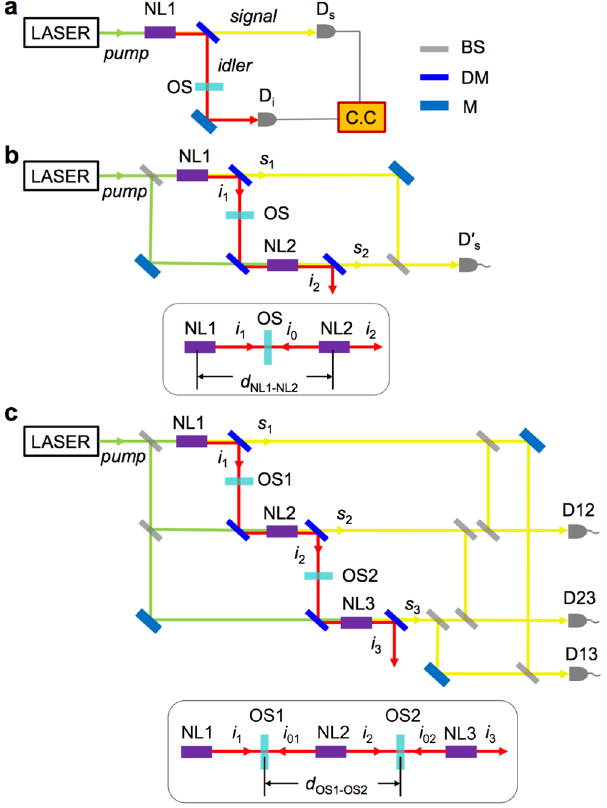
Figure 1. Schematic representations of single-, double-, and triple-SPDC experiments. Pump, signal, and idler beams are shown in green, red, and yellow in color, respectively. NL, OS, D, M, and C.C. represent nonlinear crystal, optical sample, detector, mirror, and coincidence counter, respectively. ( a ) Single-SPDC experimental setup with coincidence counting rate measurements with D s and D i . ( b ) Double-SPDC experimental setup with two NL crystals. One-photon interference (second-order interference) between s 1 and s 2 is detected by ′ D Triple-SPDC gedankenexperimental setup with three NL crystals. One-photon interference (second-order interference) between s 1 and s 2 , between s 1 and s 3 , and between s 2 and s 3 are detected by D12, D13, and D23, respectively. The inset figures of ( b and c ) represent a one-dimensional representation of idler beam pathway along its propagation